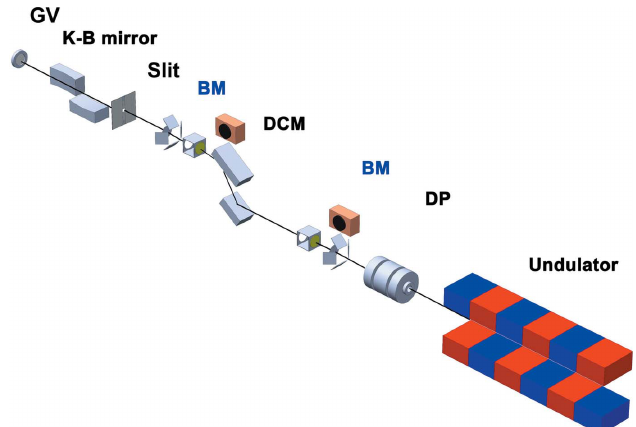
Figure 1 The layout of the hard X-ray beamline at the Pohang Accelerator Laboratory X-ray Free-Electron Laser (PAL-XFEL): differential pumping (DP), the beam monitor including the quadruple beam position monitor (BM), double-crystal monochromator (DCM), slit, a pair of Kirkpatrick–Baez (K-B) mirrors, and a gate valve